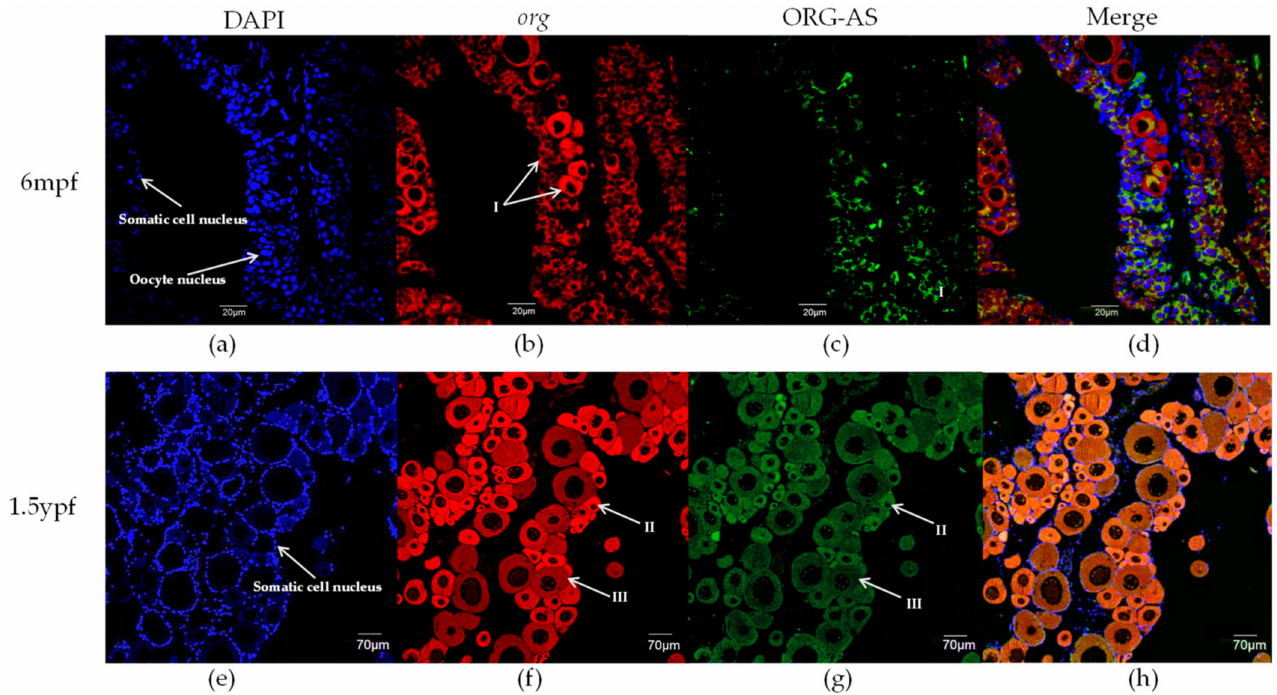
Figure 5. org and ORG-AS localization in the ovary of C. semilaevis at 6 mpf and 1.5 ypf. ( a ) Oocyte nuclei and somatic nuclei were stained with DAPI in 6 mpf ovaries; ( b ) Localization of org detected using 5 (cid:48) Cy3-labeled fluorescent probe in 6 mpf ovaries; ( c ) Localization of ORG-AS detected using 5 (cid:48) 6-FAM-labeled fluorescent probe in 6 mpf ovaries; ( e ) Somatic nuclei were stained with DAPI in 1.5 ypf ovaries; ( f ) Localization of org detected using 5 (cid:48) Cy3-labeled fluorescent probe in 1.5 ypf ovaries; ( g ) Localization of ORG-AS detected using 5 (cid:48) 6-FAM-labeled fluorescent probe in 1.5 ypf ovaries; ( d , h ) Combination of org , ORG-AS, and nucleus localization. I: phase I oogonia; II: phase II oocyte; III: early phase III